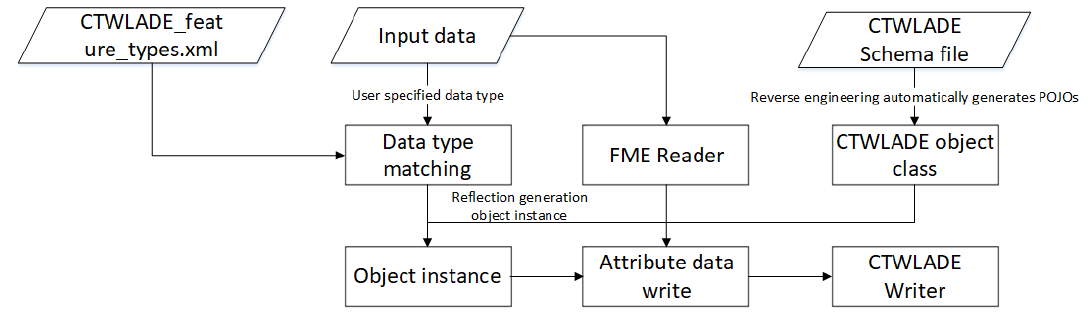
Figure 9. Attribute data integration process